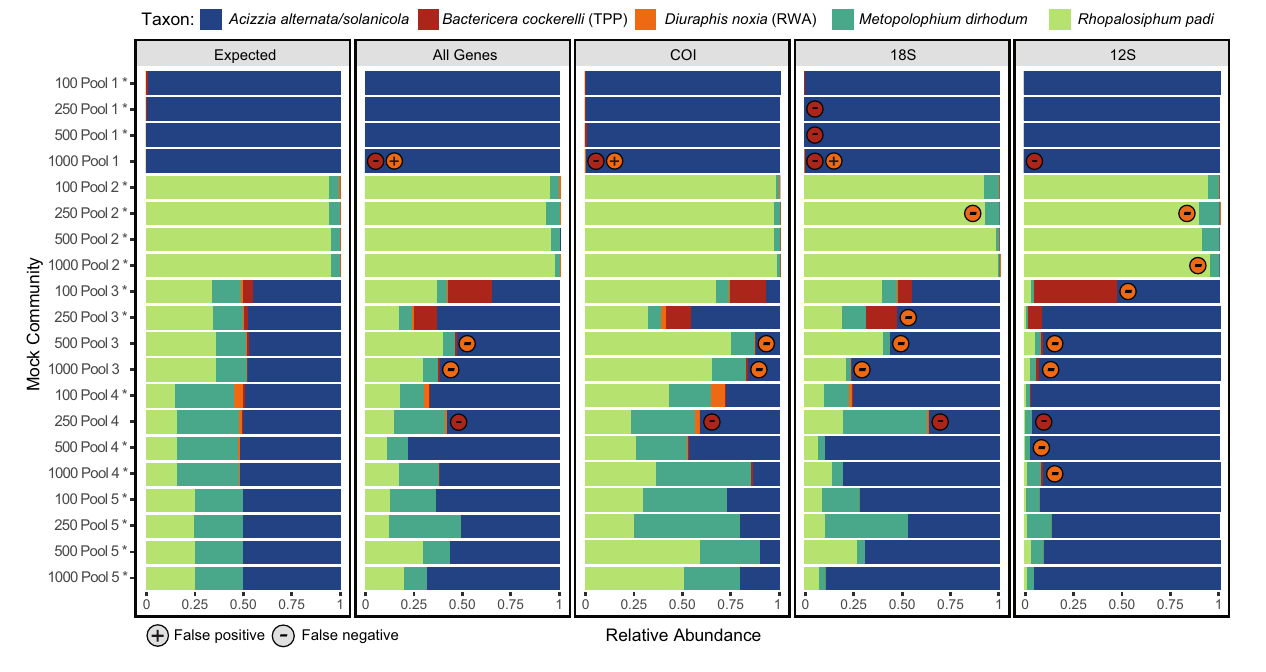
Figure 3. The expected (based on number of individuals) and observed (based on sequencing reads) relative abundance of each species in each mock community pool. Acizzia alternata and A. solanicola are aggregated for display purposes as these species could not be differentiated by the 18S loci. Observed relative abundance data is shown for the mean across the three loci, and for COI, 18S, and 12S separately. False positive and negative genera are indicated in each pool based on a detection threshold of 0.01%. Asterisks (*) indicate pools that had all species correctly identified.